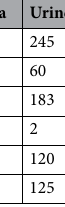
Table 2. Patient characteristics and pMMA and uMMA values of a subset of individuals from the MARLINA trial. Number of samples in each group and subgroup.